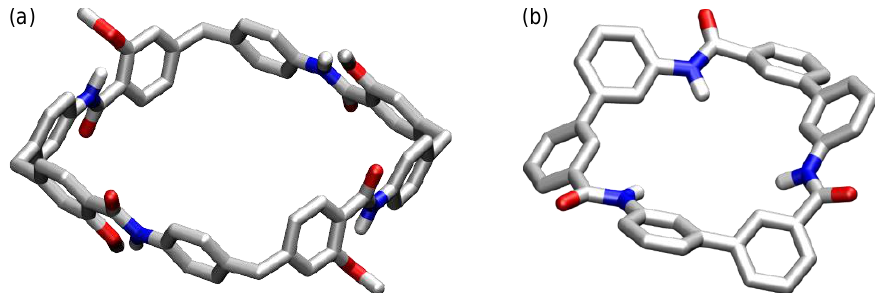
Figure 20. Calculated structures of cyclopeptides 52 ( a ) and 53 ( b ). The calculations were performed by the author of this review based on the reported results by using Spartan 20 (Wavefunction, Inc., Irvine, CA, USA) and the MMFF force-field (see Supporting Information). The side chains of all cyclopeptides are truncated and protons, except acidic ones, are omitted for reasons of clarity.